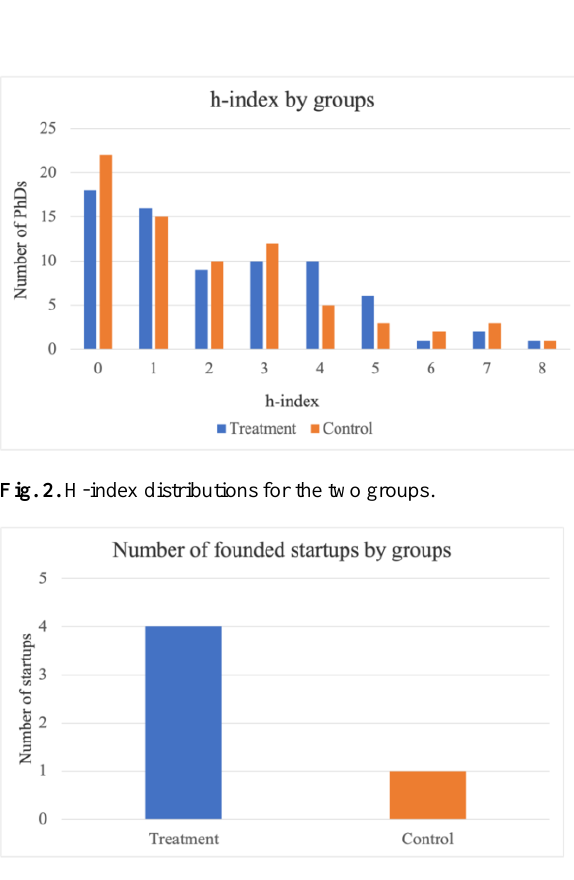
Fig. 3. Number of startups created in the two